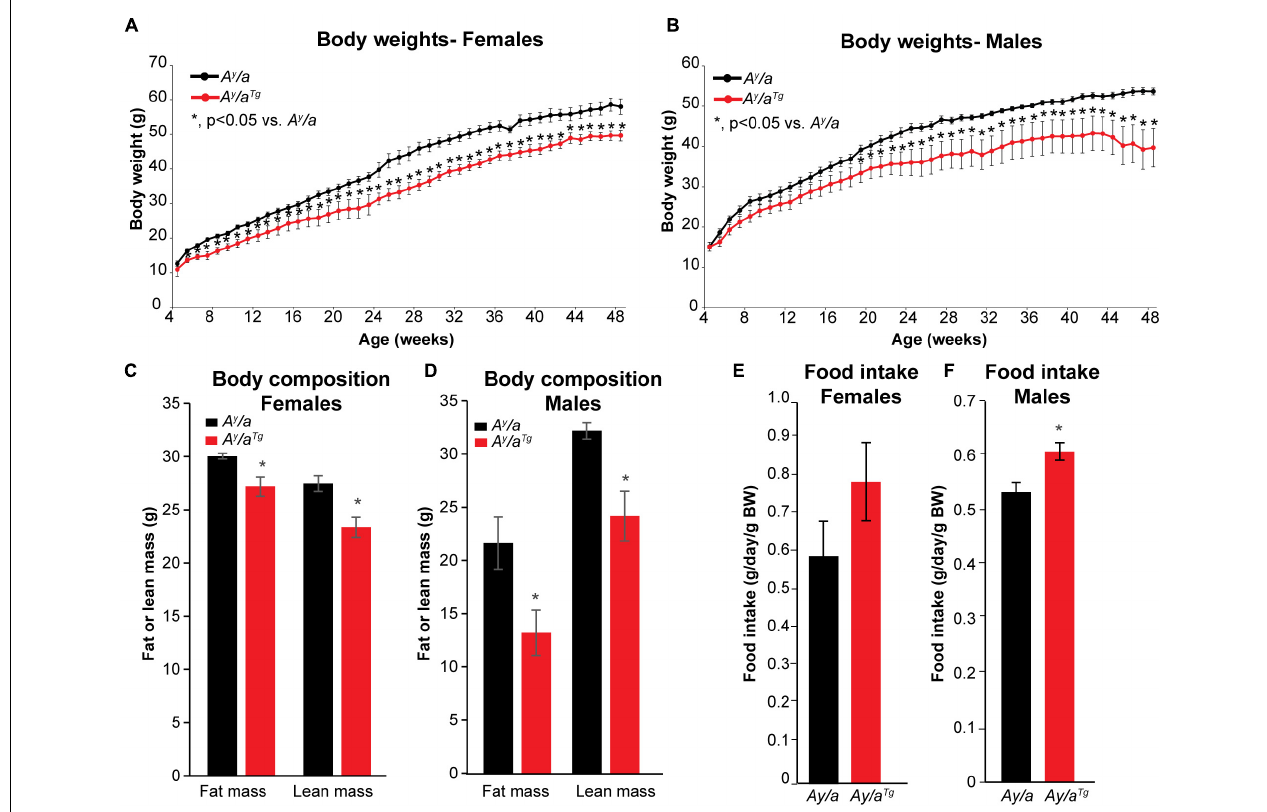
FIGURE 1 | Body weights, body composition, and food intake. (A,B) Body weights were reduced in A y /a Tg mice, relative to A y /a obese counterparts. (C,D) Reductions in both lean and fat mass were apparent in A y /a Tg mice. (E,F) Food intake was measured weekly between weeks 10–22 for males and 18–22 for females; food intake was slightly increased in A y /a Tg mice (NS in females). Averages ± SEM. * p < 0.05 vs. sex-matched A y